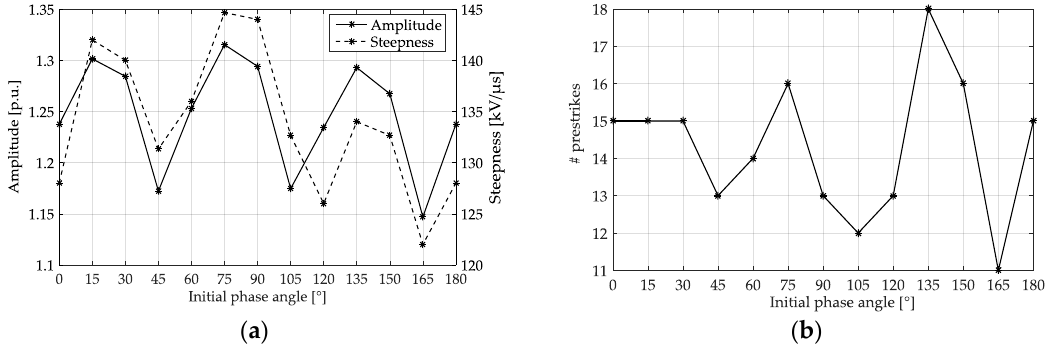
Figure 8. The relationship between different indicators of TOV and the initial closing phase angle for Scenario 1: ( a ) the amplitude and steepness; ( b ) the number of prestrikes (#prestrikes).